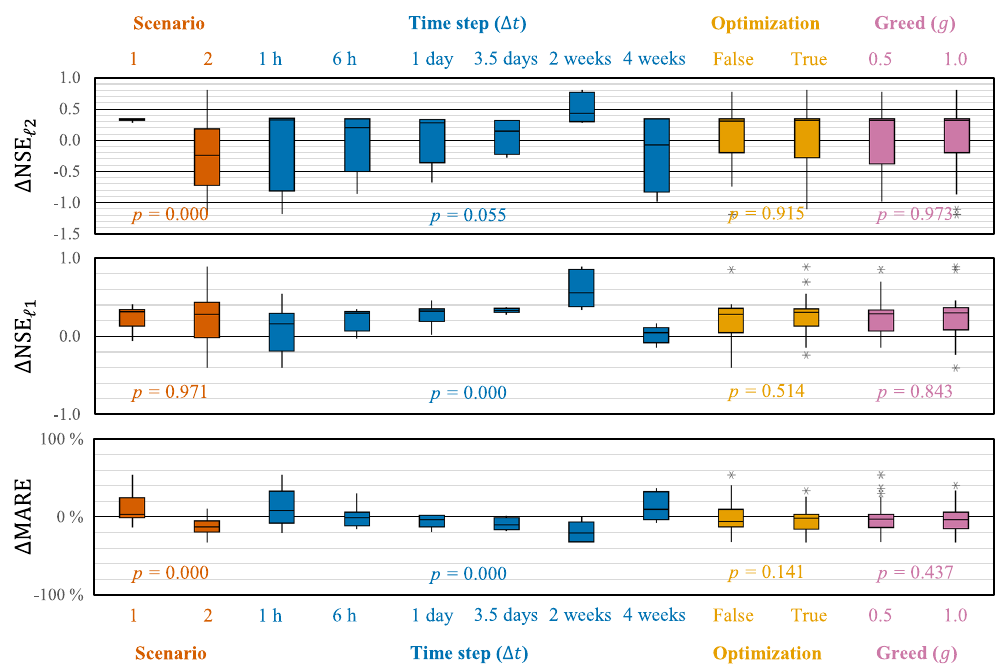
Figure 6. Box plots of the changes in forecasting performance (NSE (cid:96) , NSE (cid:96) , and MARE) achieved while using OPTIMISTS on Experi- 2 1 ment 3 (Indiantown Run). Changes are relative to an open-loop control run where no assimilation was performed. Each column corresponds to the distribution of the error metric changes on the specified scenario or assignment to the indicated parameter. Positive values indicate improvements for the NSE (cid:96) and the NSE (cid:96) . See the caption of Fig. 3 for more 2 1